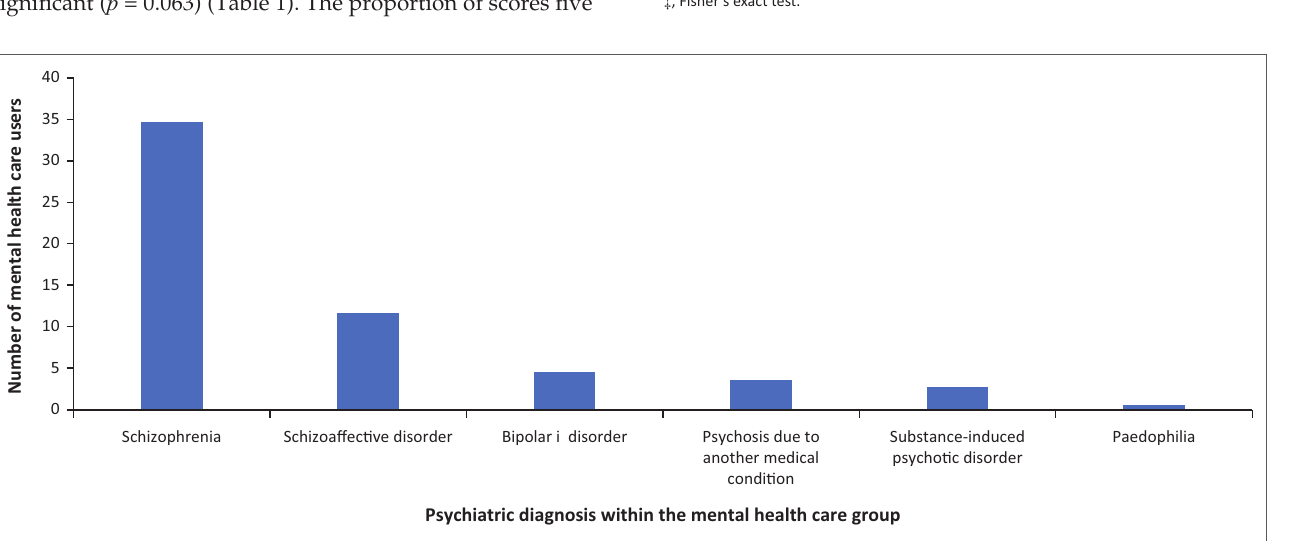
FIGURE 1: Distribution of the various psychiatric diagnoses based on (Diagnostic and Statistical Manual of Mental Disorders, 5th Edition) DSM 5 criteria within the mental healthcare group ( n = 60).